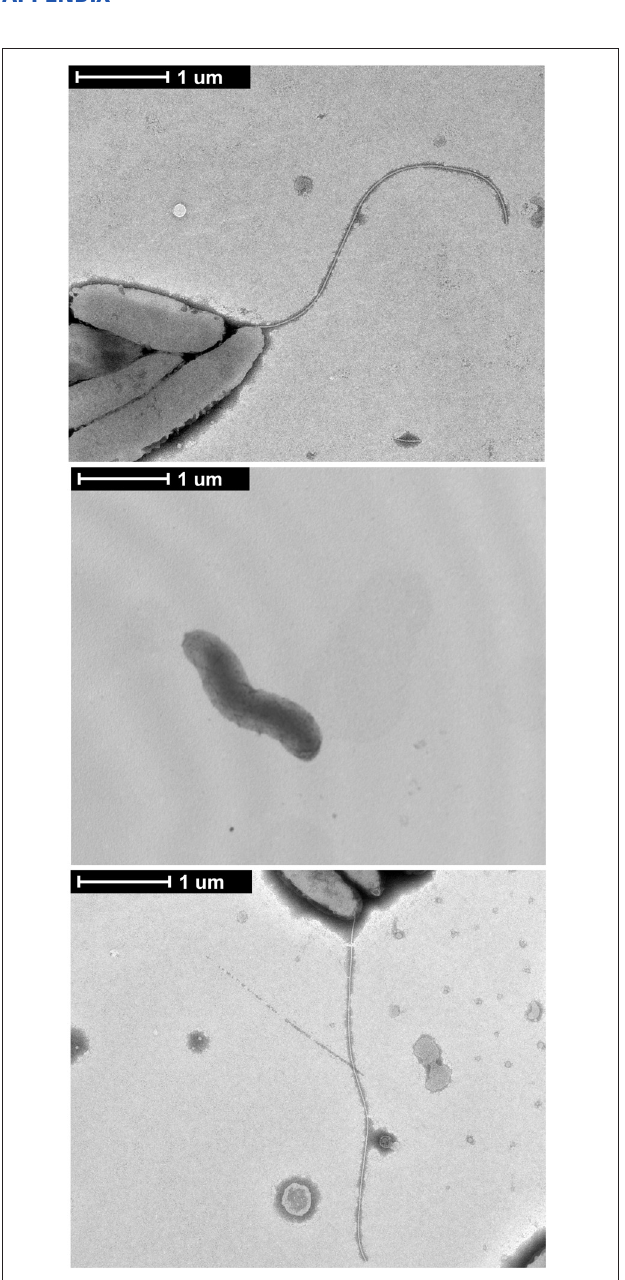
FIGURE A1 | Complementation of the C. jejuni flgL mutant with a plasmid harboring flgL restores the flagellar filament. C. jejuni wild-type strain, the flgL mutant, and flgL mutant harboring plasmid-encoded flgL were examined by TEM. C. jejuni were spotted onto formvar coated copper grids, stained with 2% phosphotungstic acid, and visualized at 6500 × magnification. The scale bar represents one micron.